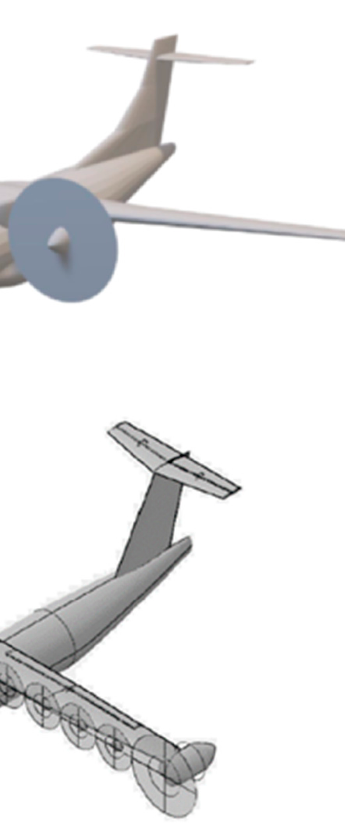
Figure 5. Motorization 2.